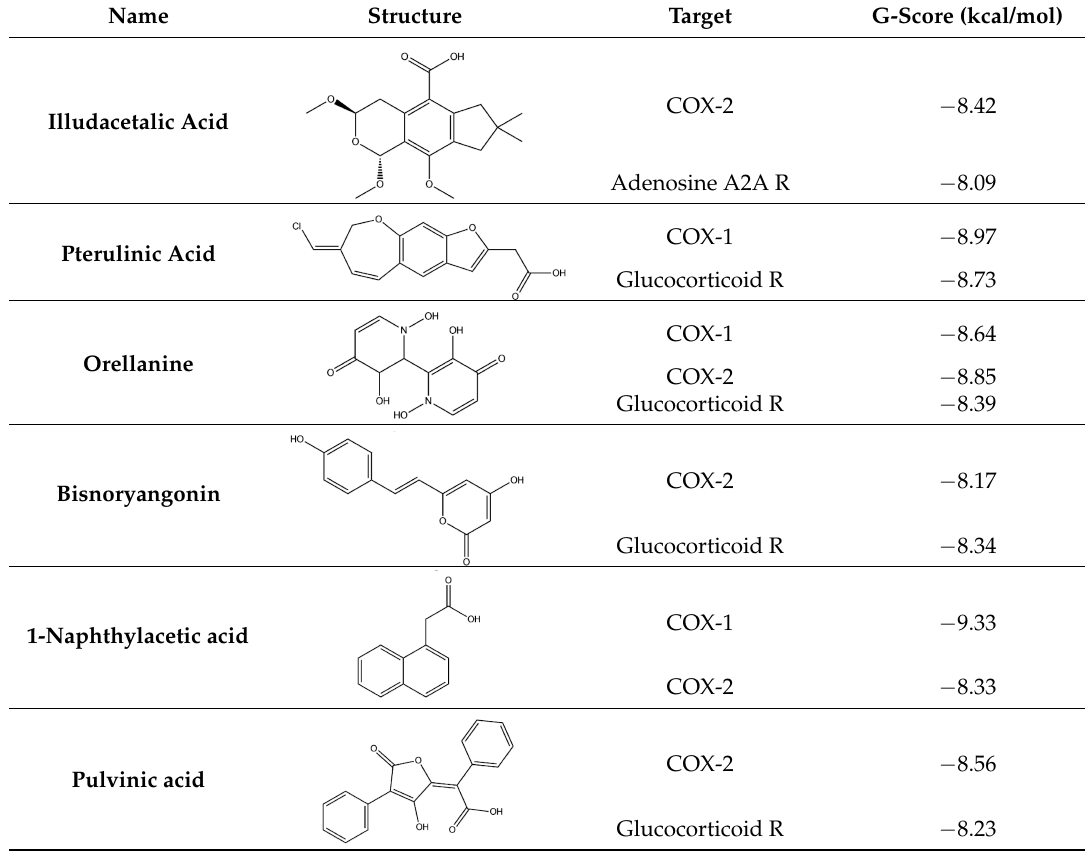
Table 2. Fungal components with best theoretical affinities (G-score) against multiple targets involved in the mechanism of inflammation.